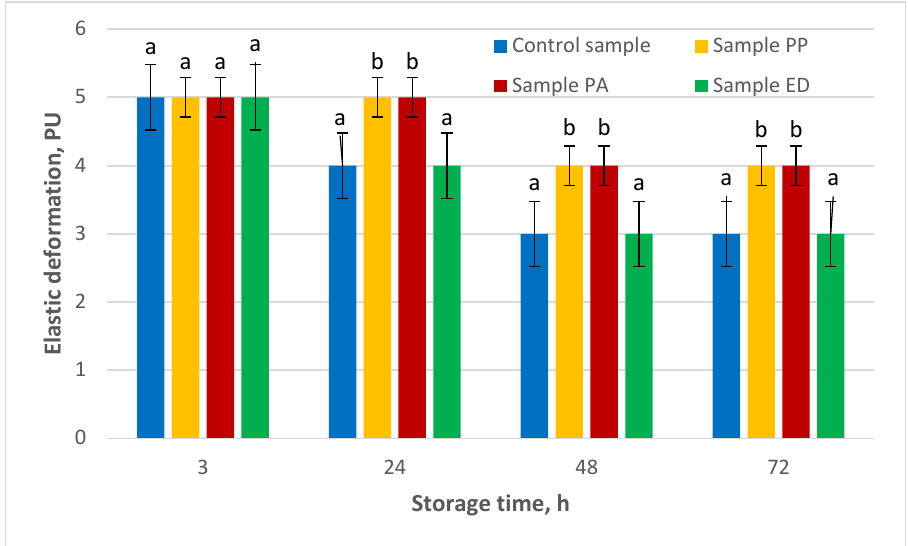
Figure 5. Effect of lactic acid bacteria on the elastic deformation of nongluten bread. Note: PU — penetrometric units; PA — sample with Pediococcus acidilactici 02P108; PP — sample with Pediococcus pentosaceus 12R2187; ED — sample with Enteroccocus durans 09B374. Different small letters for each time measurement indicate significant difference between mean values ( p < 0.01).